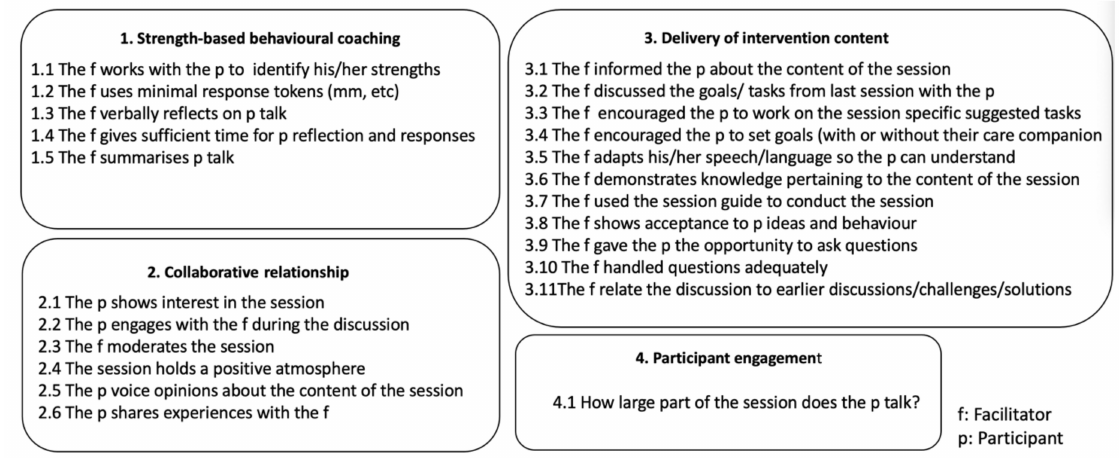
Figure 3. Statements and question included in the interaction scoring